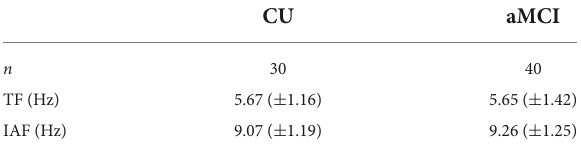
TABLE 4 Mean values ( ± SD) of the transition frequency (TF) and individual alpha peak (IAF) computed from resting state EEG (rsEEG) eLORETA source solutions (normalized source current density) in the groups of cognitively unimpaired (CU) and amnestic mild cognitive impairment (aMCI)